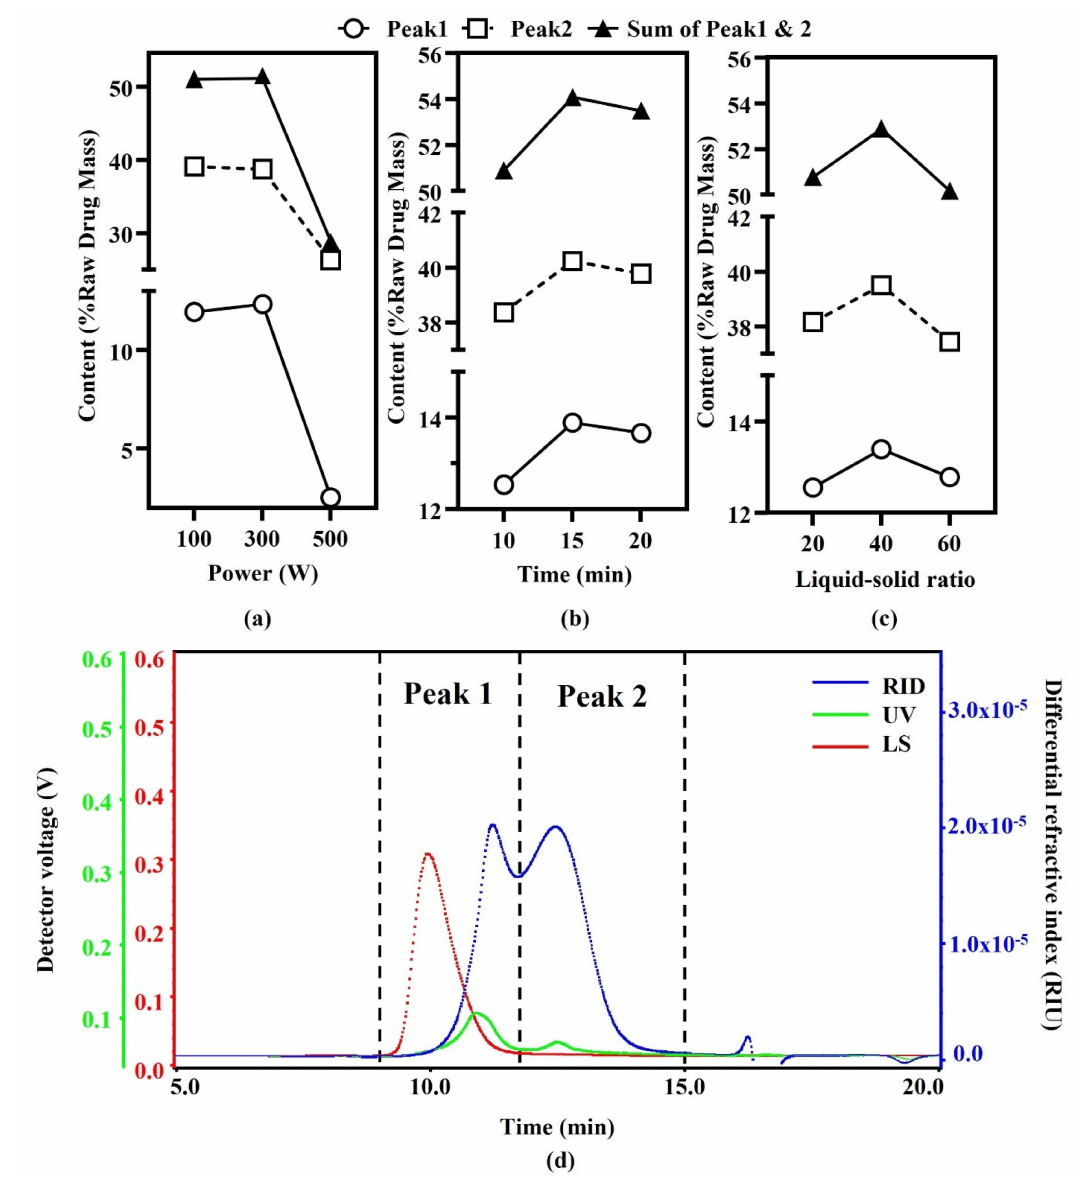
Figure 1. Effect of microwave power ( a ), extraction time ( b ), and liquid-solid ratio ( c ) on extraction efficiency of polysaccharides from Ophiopogon japonicus in Zhejiang based on ( d ) HPSEC-MALLS-RID chromatogram with peaks 1 and